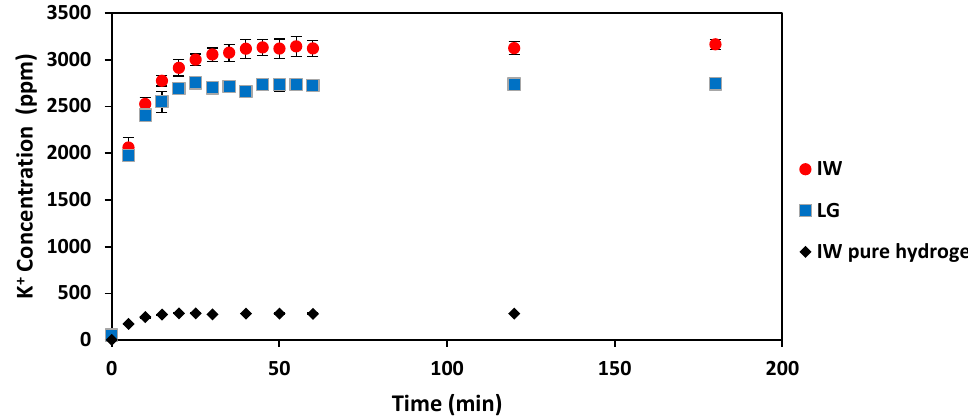
Figure 2. Concentration of K + released during the nutrient release tests for produced slow-release fertilisers (5 wt% alginate in LG and 3.3 wt% IW) over 180 min. The error bars indicate the standard deviation from triplicate experimental runs.